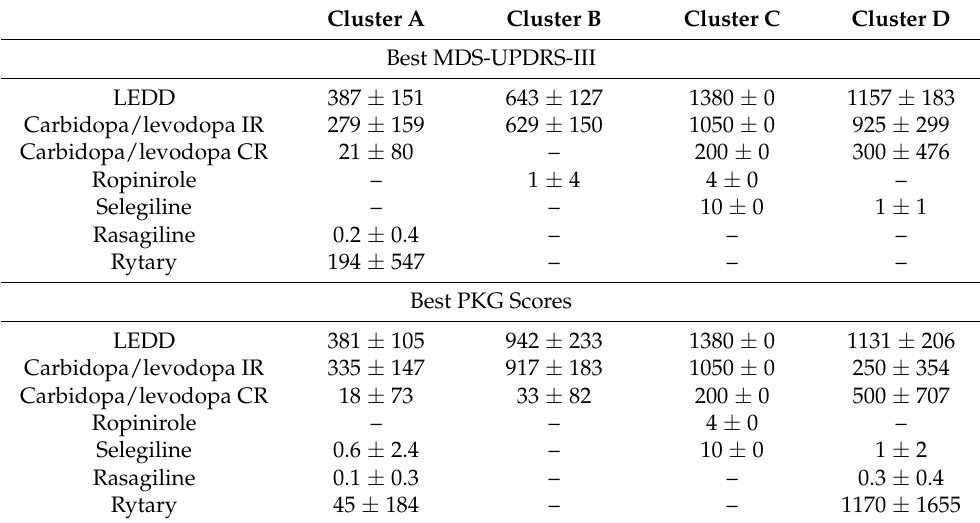
Table 3. Dosage and medication types for clusters depicted in Figure